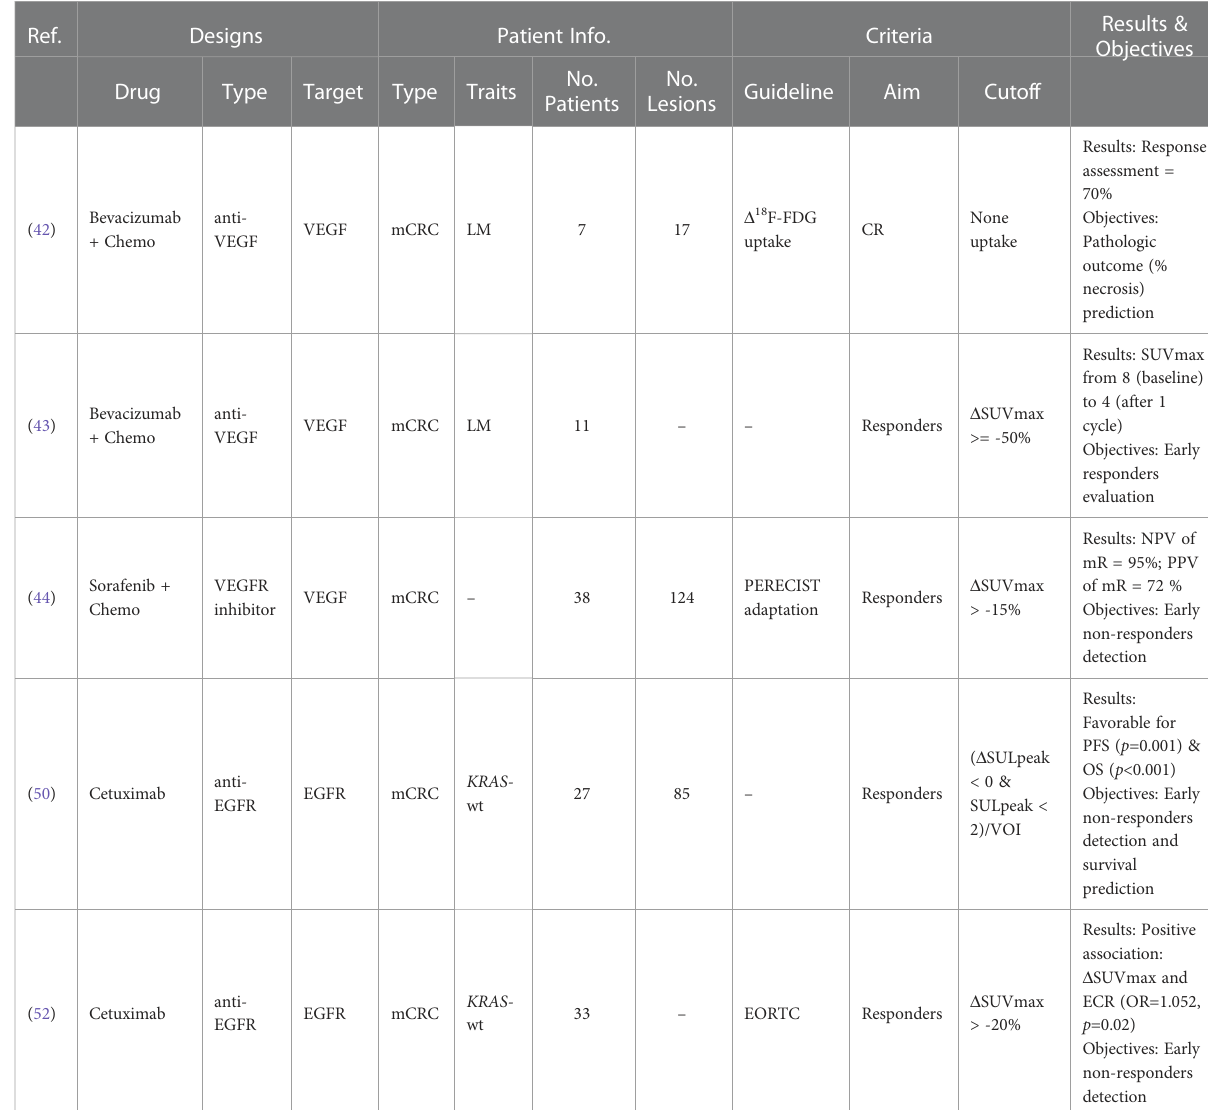
TABLE 2 Evaluation of treatment response to targeted therapy by 18 F-FDG PET/CT.